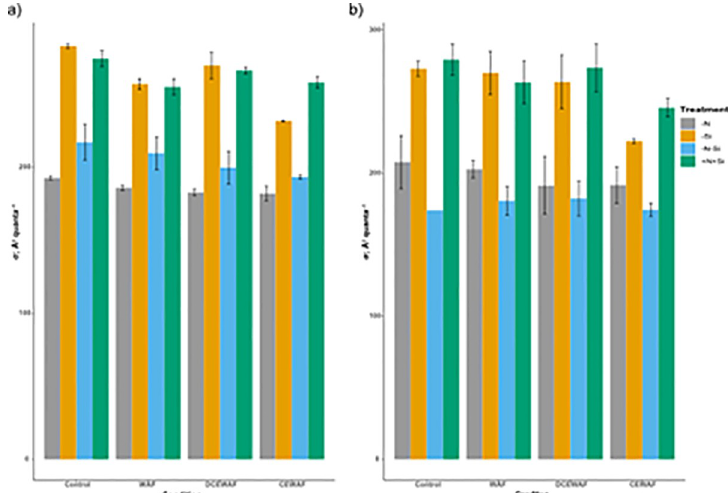
Fig 4. Photosystem II antennae size of P . tricornutum . a) average absorption cross-section area on Day 1 ( σ ; Å 2 quanta –1 ), b) average absorption cross-section area on Day 4 ( σ ; Å 2 quanta –1 ) ( ± standard deviation) under different treatments and conditions (n = 3). The symbols–N, -Si, -N-Si, and +N+Si indicate nitrogen limited, silica limited, both nitrogen and silica limited and nitrogen and silica replete treatments.